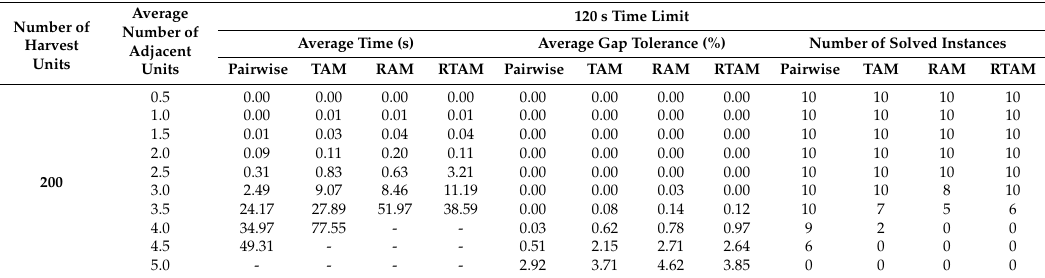
Table 7. Solving time, gap tolerance and number of solved instances for 120 s time limit and 200 harvest